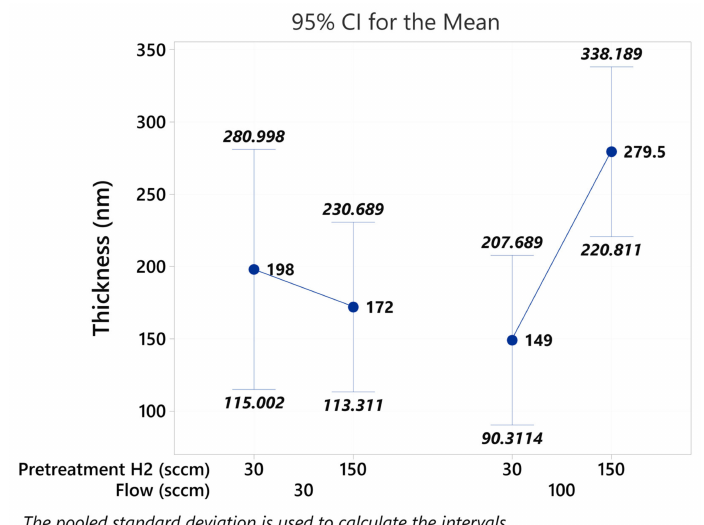
Figure 6. Interval Plot of Thickness (nm) with Interaction Flow × Pretreatment H 2